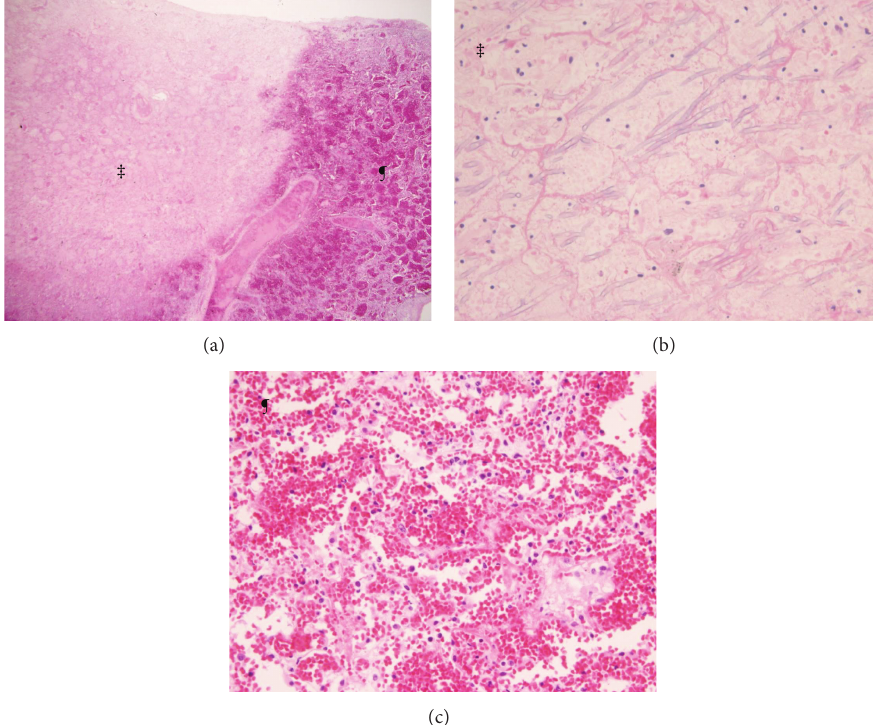
Figure 1: Invasive pulmonary aspergillosis, discrete nodule. (a) The nodule comprises coagulation necrosis of the lung tissue ( ‡ ) and acute hemorrhage usually accompanies the necrosis (¶) and may mimic a halo sign on CT (Hematoxylin-Eosin, X20). (b) Zone formation (mimicking an annual ring) of hyphae aligned in a radial pattern. Few inflammatory infiltrates are accompanied in the lesion (Hematoxylin- Eosin, X200). (c) Acute hemorrhage can be seen. No hyphae can be